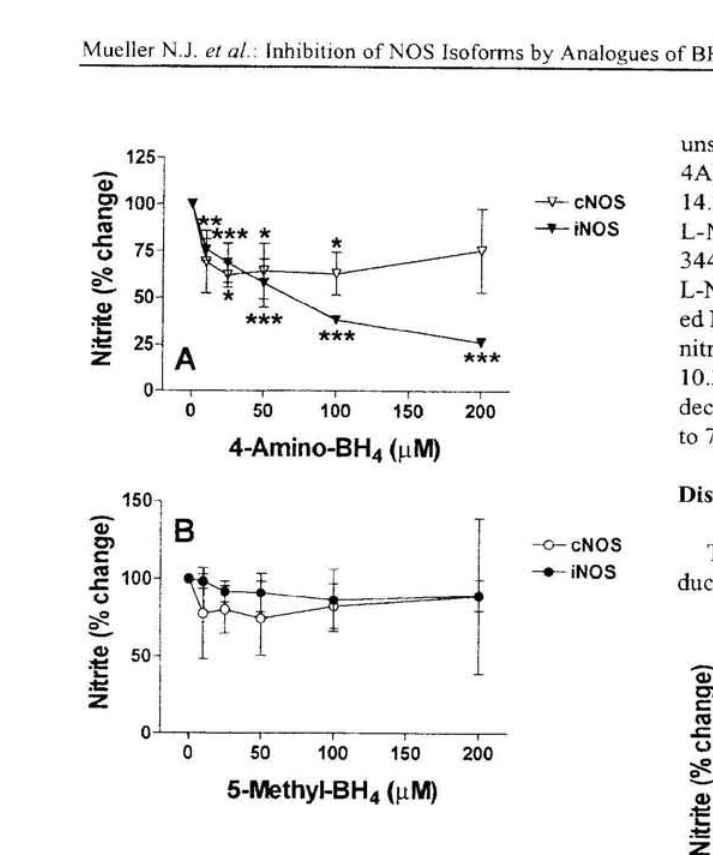
Figure 3. Effects of the pîeridine analogues 4-amino- BH4 and 5-methyl-BH4 on NO production by MVEC.